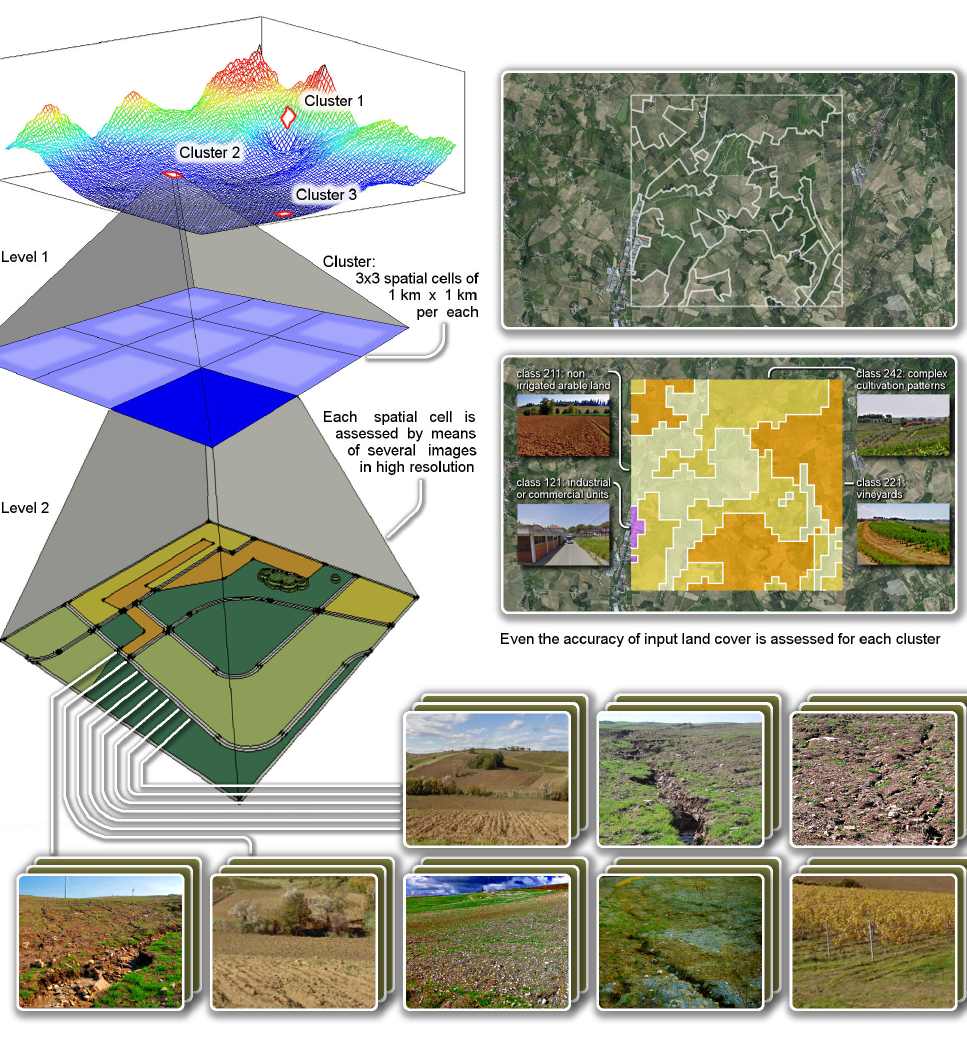
Figure 1. The e-RUSLE application to pan-European scale produces estimates of soil erosion by water which are aggregated at 1km × 1km spatial cell. These estimates also depend on the quality of input land cover information. An expert-based plausibility check was performed over random clusters of 3 × 3km 2 grid cells (Level 1) by integrating Google Earth and Bing higher-resolution information which also includes (Level 2) high-resolution images – Google Street View images; georeferenced crowd-sourced pictures. The plausibility of Corine Land Cover 2006 was also checked to investigate the influence of land cover misclassification (even due to land cover changes occurred since 2006). Image from Bosco et al. (2014); Bing Maps, © 2013 Microsoft Corporation; Google Street View, © 2013 Google Inc., Mountain View,